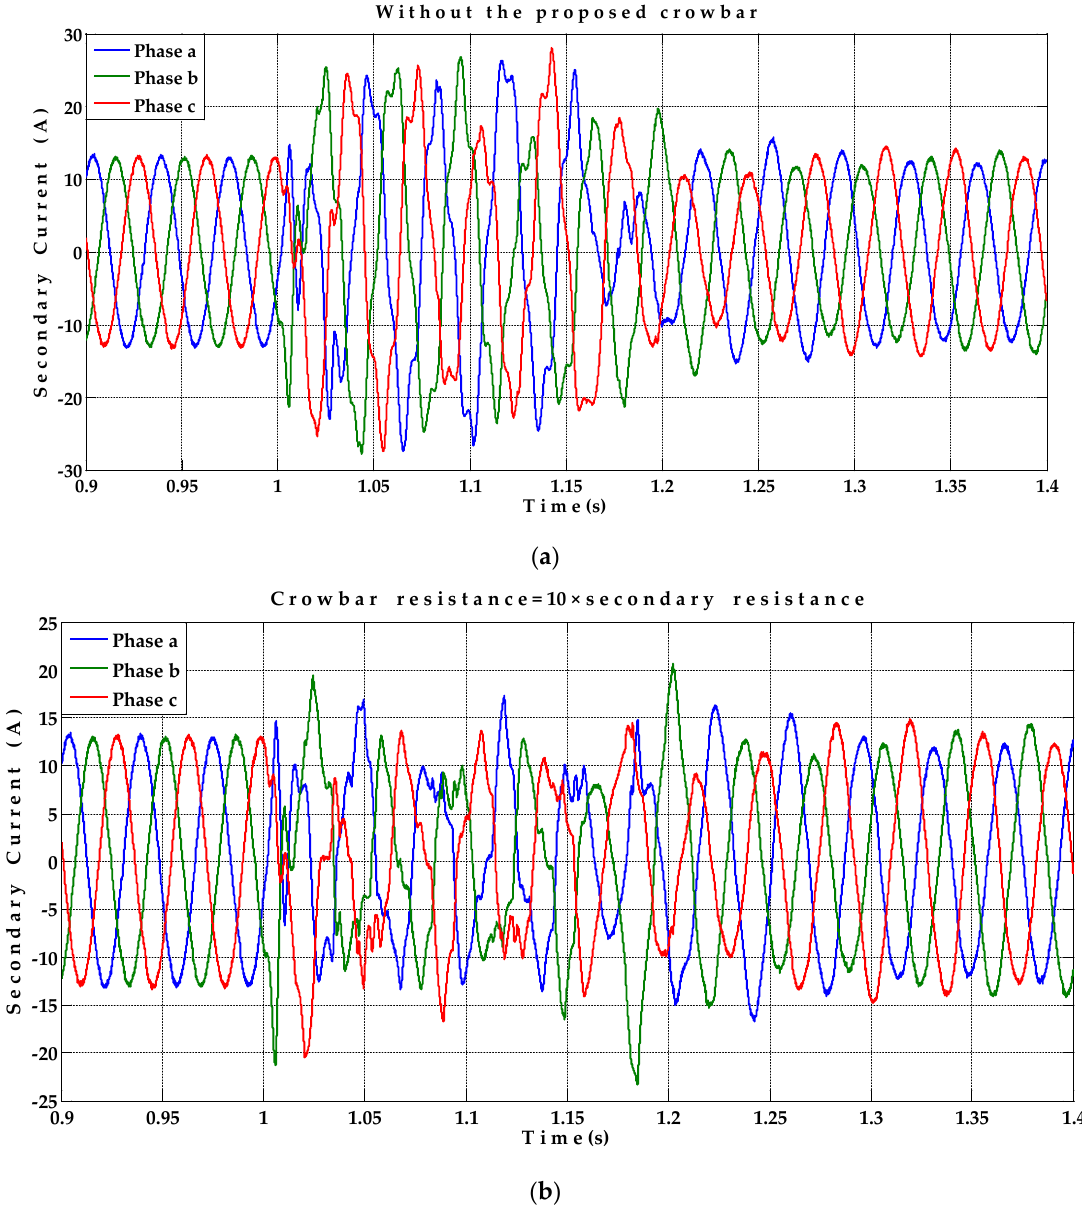
Figure 27. Secondary current of BDFRG without and with the proposed crowbar under line-to-line fault occurrence: ( a ) Without the proposed crowbar; ( b ) With the proposed crowbar. The dc link voltage of the BDFRG (with and without using the proposed crowbar) is shown in Figure 28, which has a reference value equal to 710 V. Under the fault occurrence, in the case of “without using the proposed crowbar”, the dc link voltage was decreased to about 584 V. In the case of using the proposed crowbar, the dc link voltage, during the fault, at first decreased to 690.5 V and then increased to about 777 V, then the dc link voltage improved and returned to its pre-fault value.